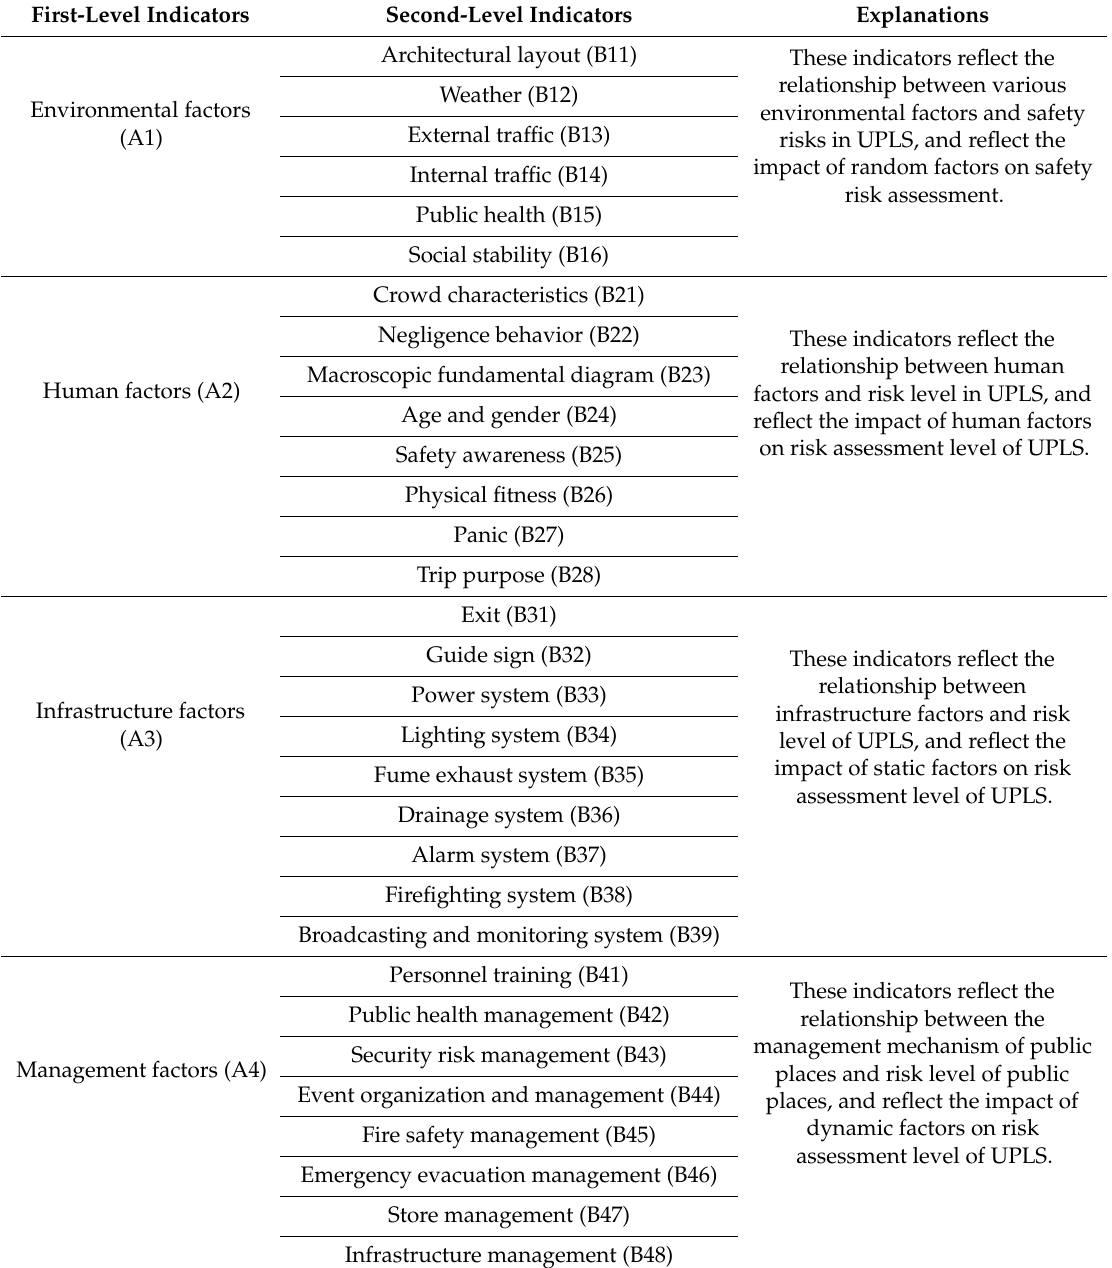
Table 2. Preliminary risk assessment index